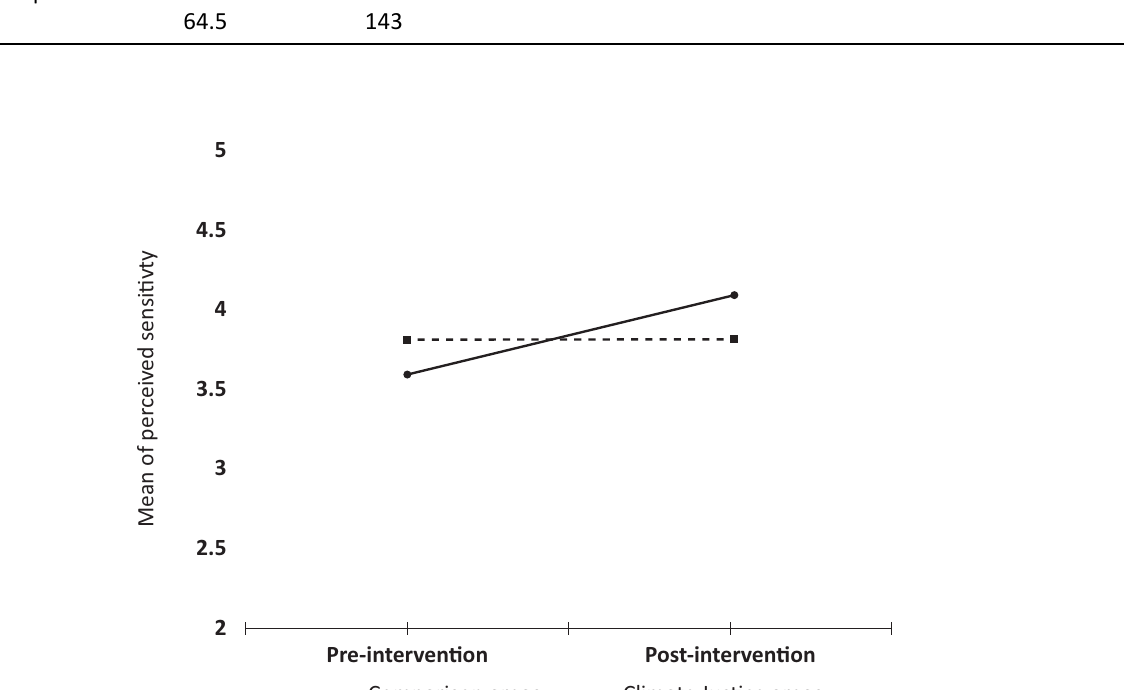
Figure 4. The effects of Climate Justice mapping intervention and group on participants’ scores of perceived sensitivity to future extreme